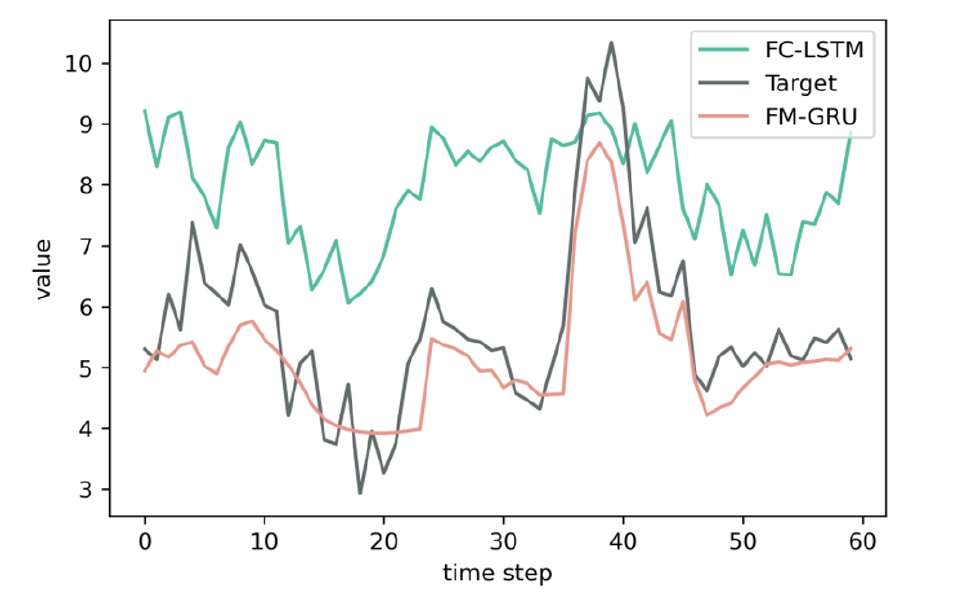
Figure 8. Fitting comparison of the predicted value of dissolved